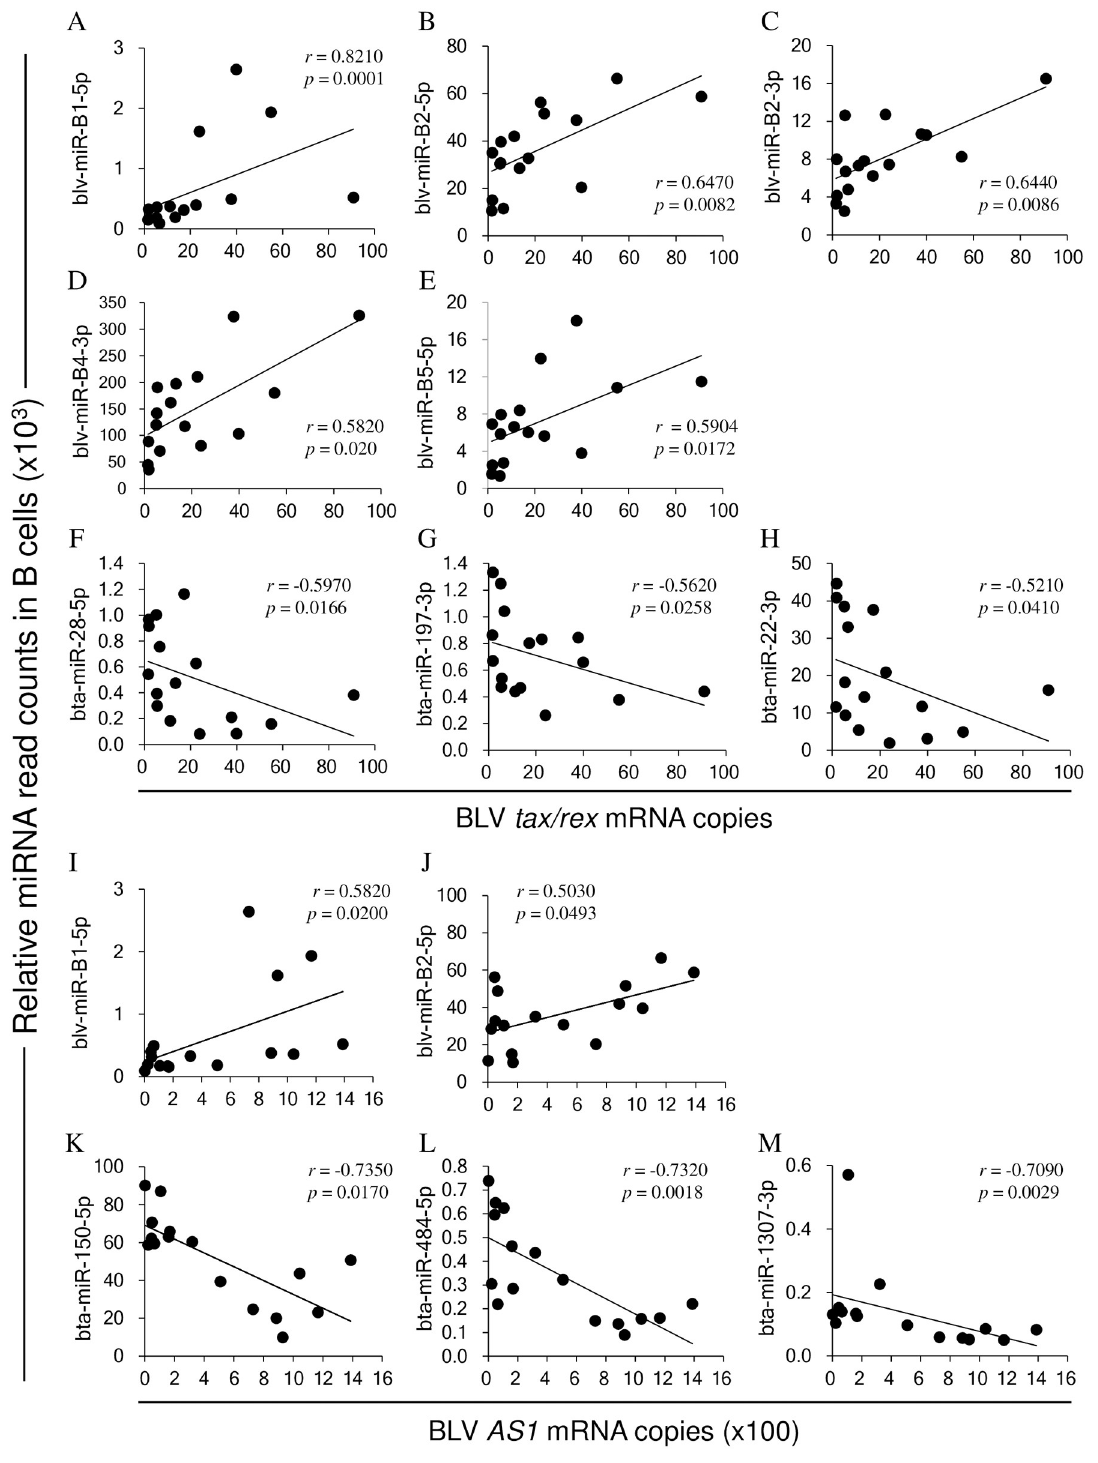
Fig 3. Correlations between BLV tax/rex and AS1 mRNA expression levels against BLV miRNA (blv-miRNA) and bovine-derived miRNA (bta-miRNA) read counts in B cells derived from BLV-infected cattle. All read counts of blv-miRNAs and bta-miRNAs were normalized to read counts of bta-miR-16a-5p. (A–H) BLV tax/rex and (I–M) AS1 mRNA copy numbers were normalized to GAPDH mRNA copy number. Data were analyzed by Spearman’s correlation coefficient test; r , correlation coefficient; p , p value.